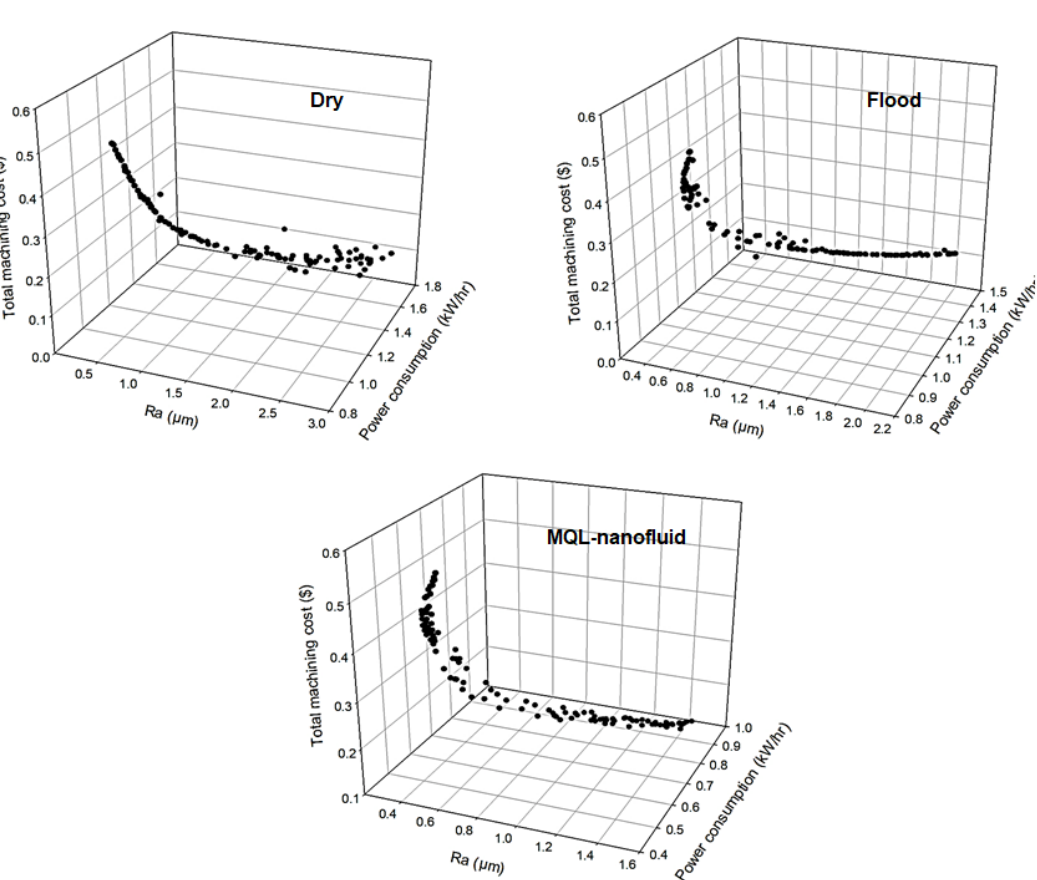
Figure 11. The selected optimal results for Model II (sustainability performance-based model).